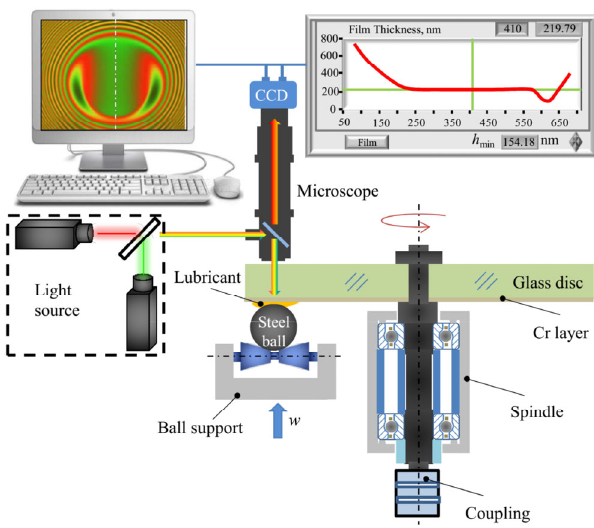
Fig. 1 Schematic diagram of the test rig and measurement